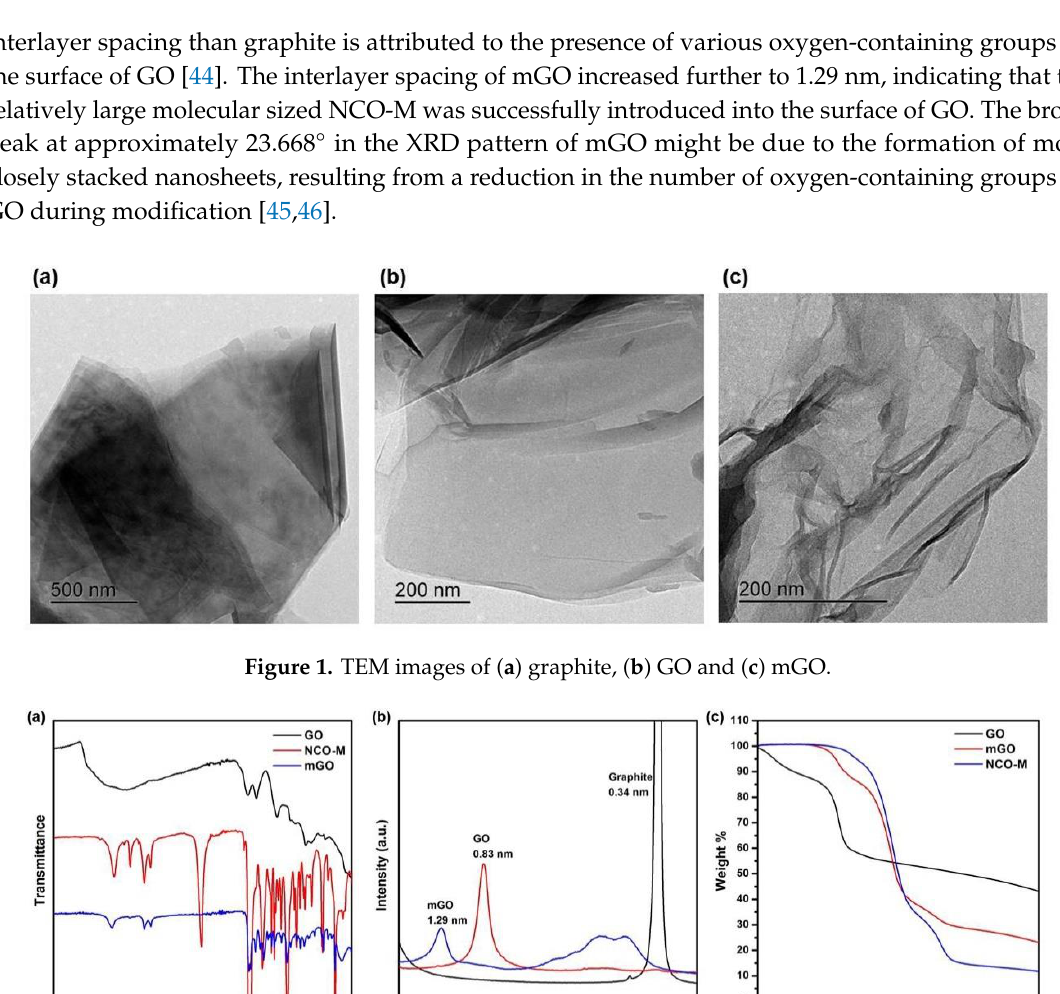
Figure 1. TEM images of ( a ) graphite, ( b ) GO and ( c ) mGO.